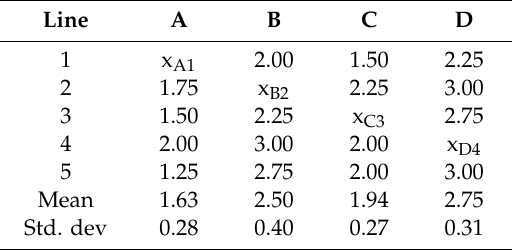
Table 1. Sample phenotypic data for five lines and four trait–environment combinations (A, B, C, and D). Line A